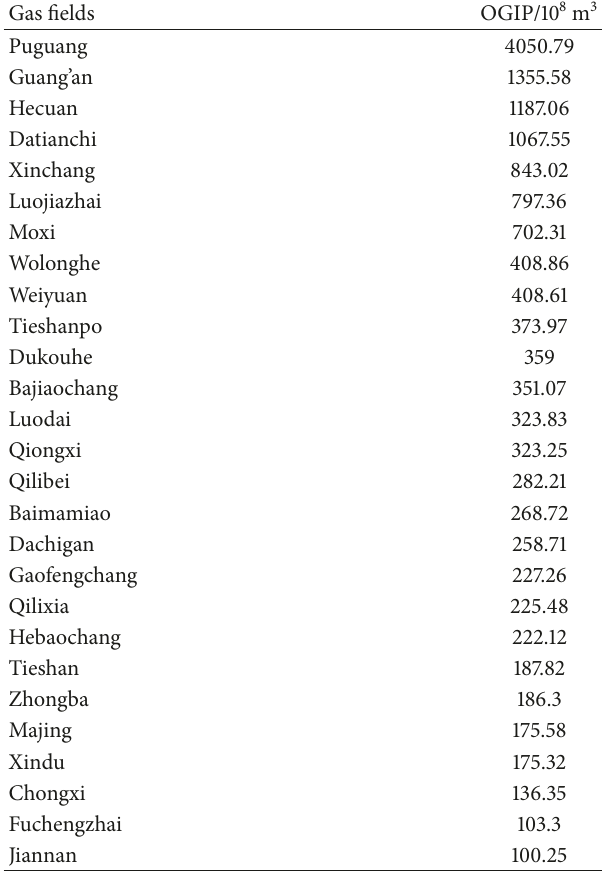
Table 7: Proven OGIP of 27 natural gas fields in the Sichuan